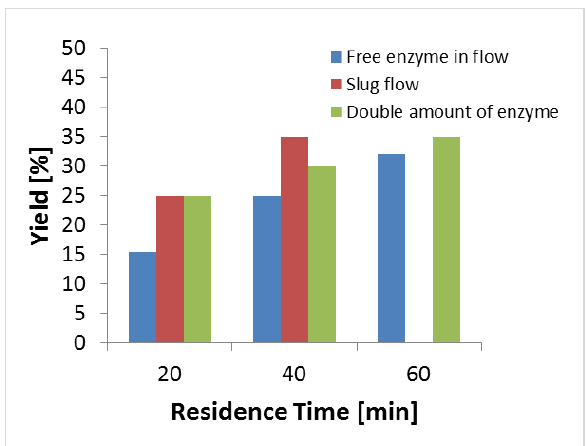
Figure 7: Effect of residence time on yield for free enzymes in a Teflon tube microreactor at 70 °C. Reaction conditions: For free enzyme in flow: Reaction volume (0.500 mL), TA (0.135 mg, specific activity – 0.135 U/mg). Slug flow: Reaction volume (0.500 mL), TA (0.135 mg, specific activity – 0.135 U/mg). Double amount single phase: Reaction volume (0.500 mL), TA (0.27 mg, specific activity – 0.135